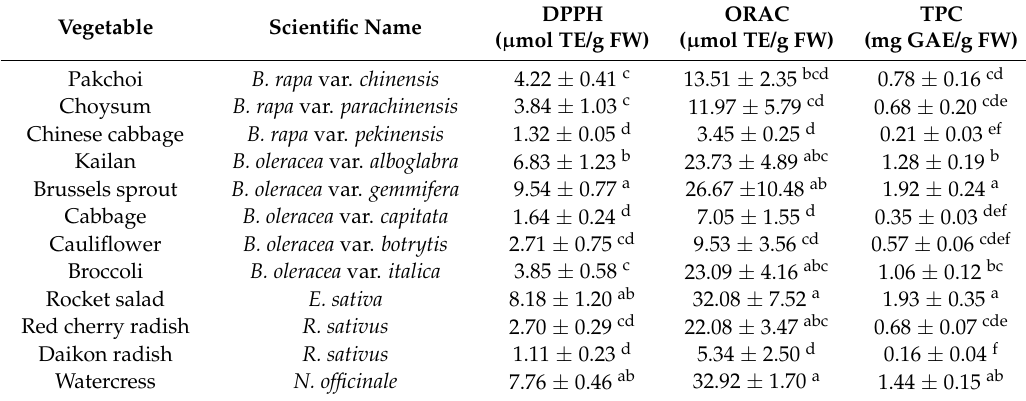
Table 2. DPPH radical scavenging activity, oxygen radical absorbance capacity (ORAC) and total phenolic content (TPC) of cruciferous vegetables. Data are expressed as mean ± standard error of mean (SEM), ( n = 3). Different letters ( a–f ) implies significant differences between groups in the same assay ( p < 0.05).